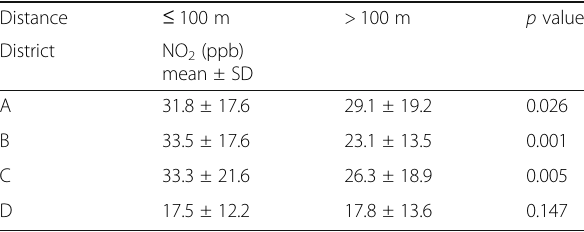
Table 2 The difference in concentration of NO 2 due to a distance from traffic major road Distance ≤ 100 m > 100